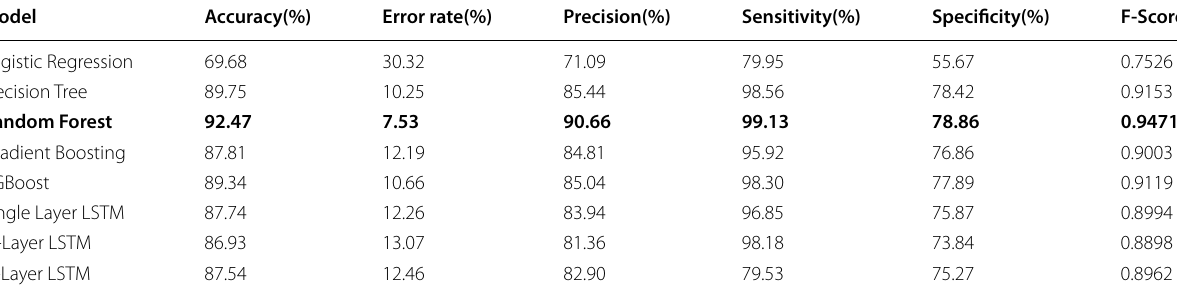
Table 6 This table presents the performance results of each predictive model for the task level based on the training dataset, where the model in bold represents the best model Model